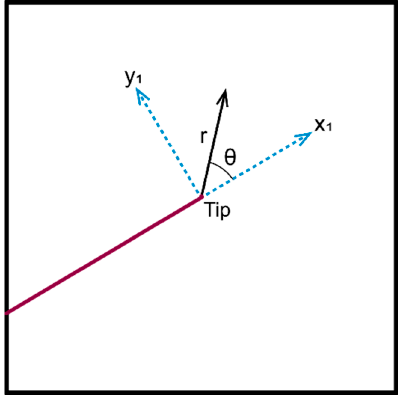
Figure 2. Polar coordinate of a fracture tip .